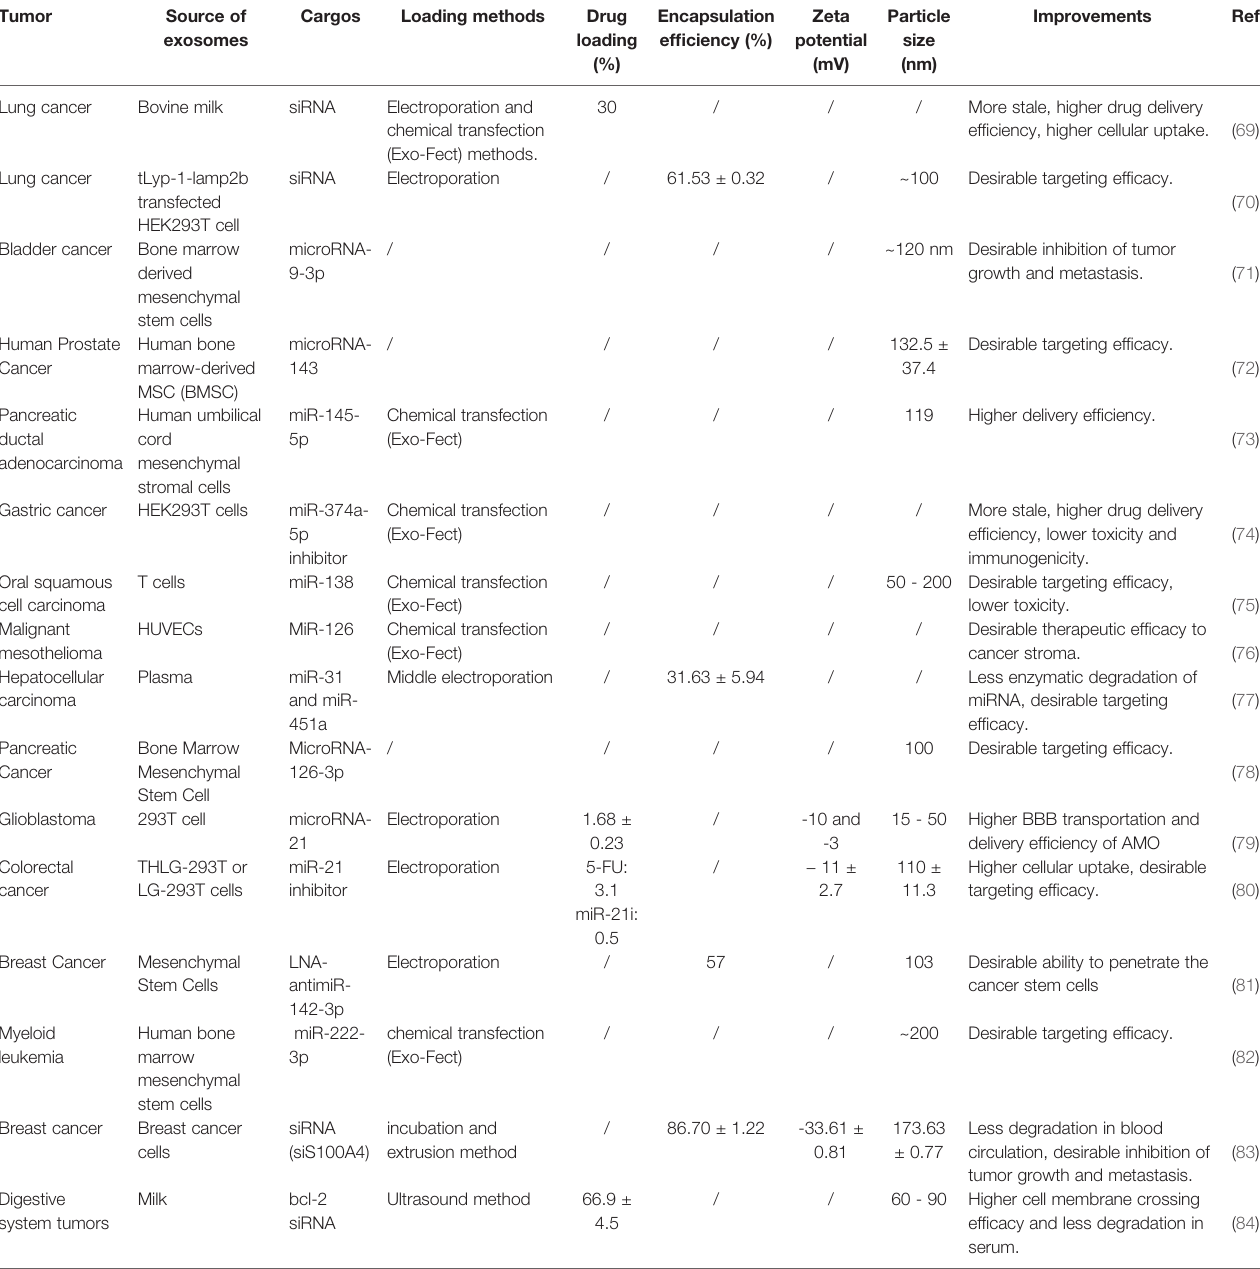
TABLE 2 | Exosome-mediated siRNA